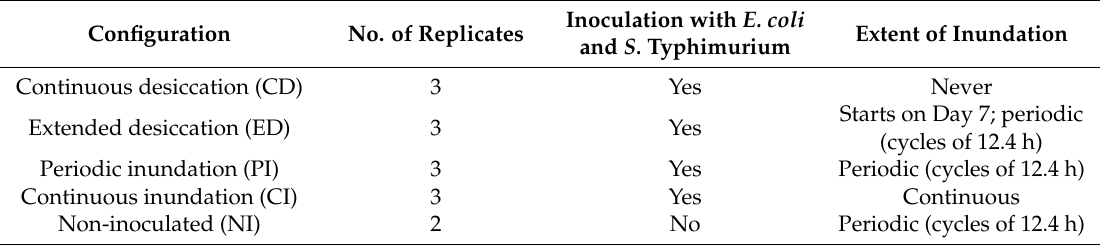
Table 1. Experimental configurations tested for survival of E. coli and S. Typhimurium and their